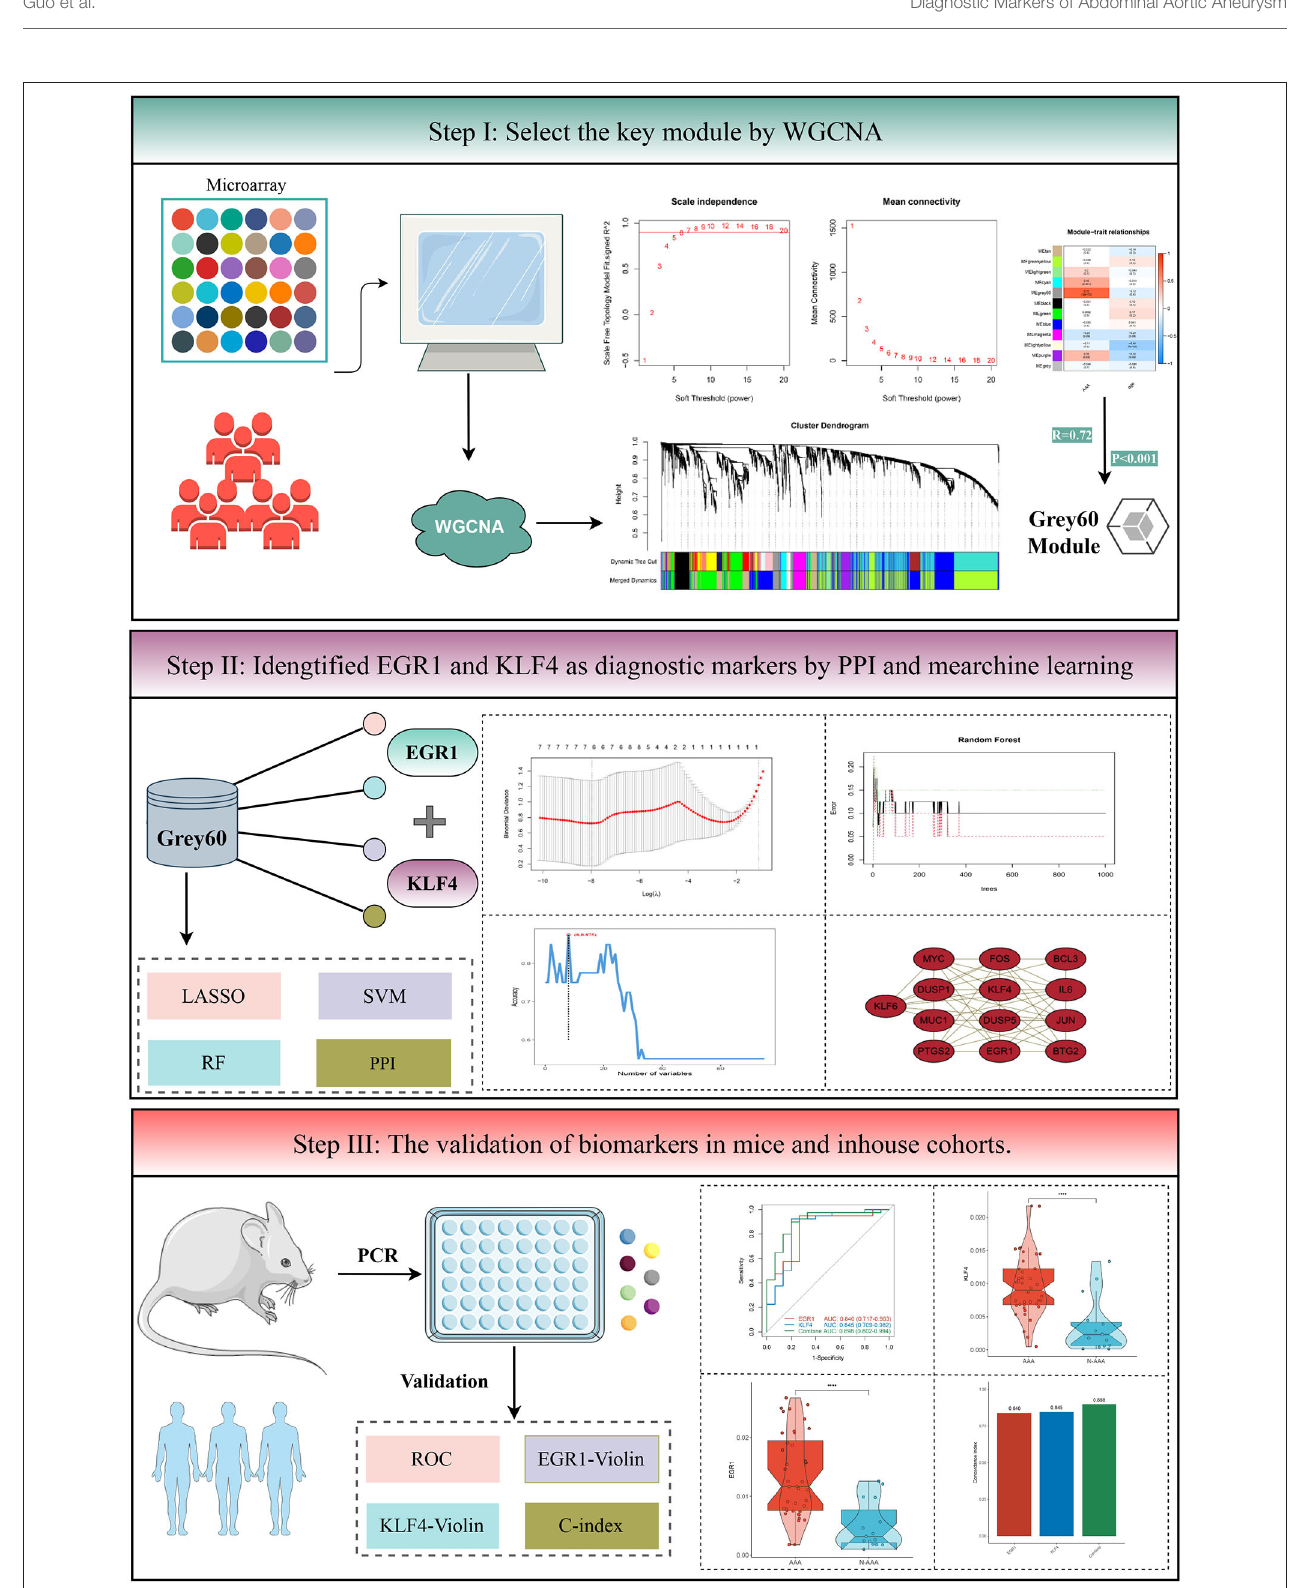
FIGURE 1 | The flowchart of analysis